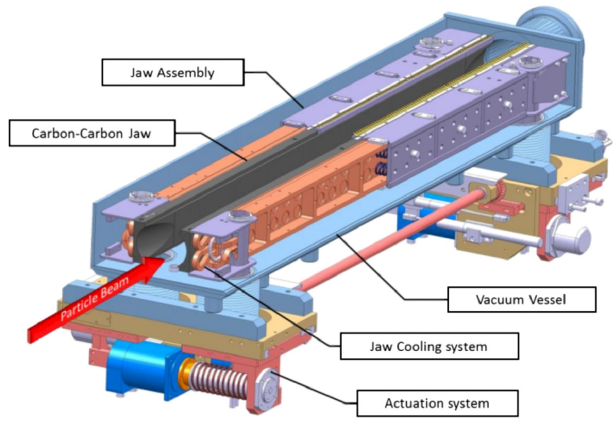
FIG. 1. Cutaway of a secondary collimator as a beam intercepting device with the active component made of a fiber-reinforced carbon jaw